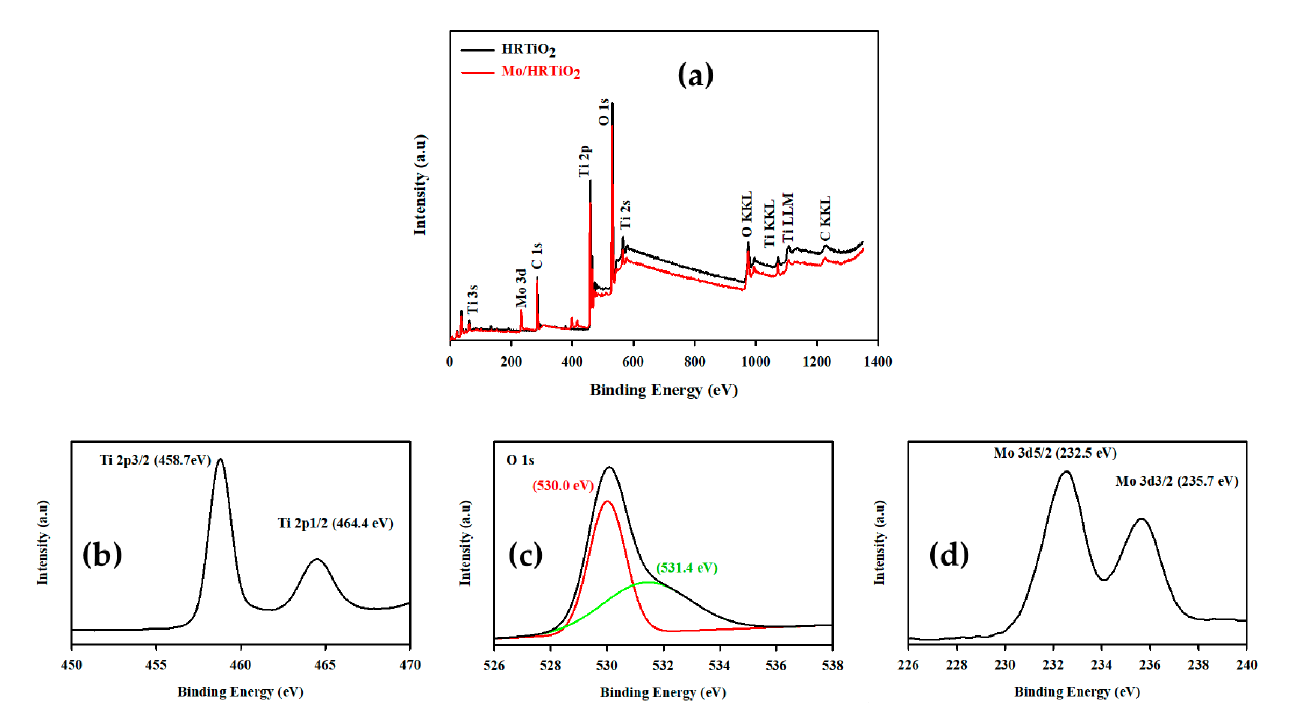
Figure 4. XPS measurement. ( a ) Survey spectrum of unmodified HRTiO 2 (black line), and modified Mo/HRTiO 2 (red line) and deconvoluted elemental spectra of ( b ) Ti 2p, ( c ) O 1s, and ( d ) Mo 3d for the modified Mo/HRTiO 2 sample only.